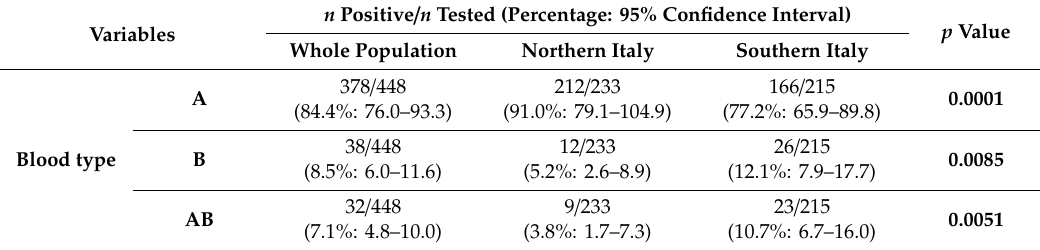
Table 1. Blood type prevalence of AB blood group system in cats from regions of Northern (Lombardy) and Southern (Sicily) Italy.